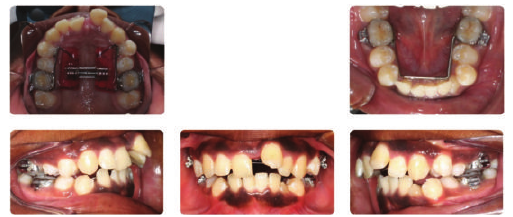
Figure 7: Progress photographs.